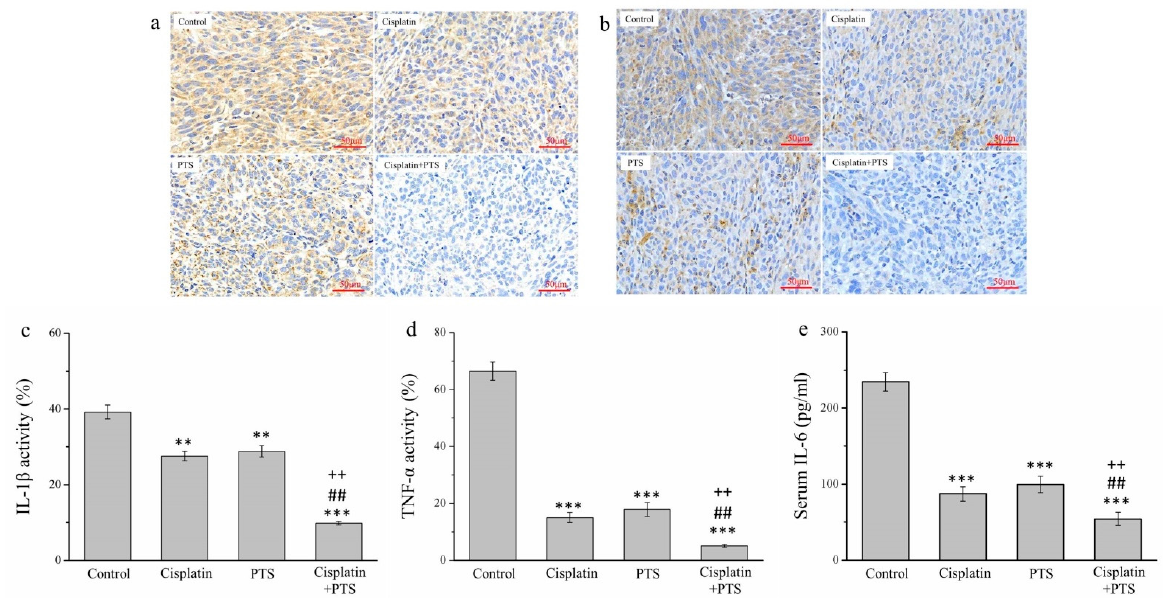
Figure 4. Immunohistochemical (IHC) analysis of the expression of three inflammatory cytokines in M5 canine melanoma tumors implanted in BALB/c nude mice. ( a , b ) Representative images showing IL-1 β ( a ) and TNF- α ( b ) expression. ( c – e ) Quantitative analyses of the IHC expression of IL-1 β ( c ), TNF- α ( d ), and serum IL-6 ( e ). The mice were administered the following treatments three times per week: saline (control), 2 mg/kg cisplatin (cisplatin), 100 mg/kg PTS (PTS), or 100 mg/kg PTS and 2 mg/kg cisplatin (cisplatin + PTS). Data are presented as mean ± SD, n = 7 per group. ** p < 0.01 and *** p < 0.001 vs. control; ## p < 0.01 vs. cisplatin; ++ p < 0.01 vs. PTS. Scale bars: 50 µ